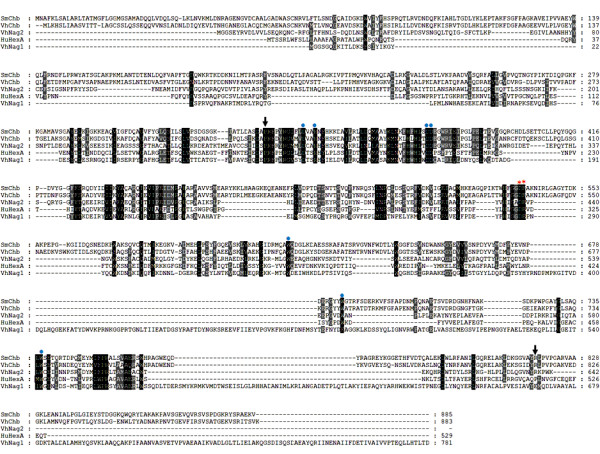
Amino acid sequence alignment of five GH-20 GlcNAcases. The sequence alignment was generated by CLUSTAL W and displayed by Genedoc. The amino acid sequence of S. marcescens chitobiase: SmChb (Swiss-Prot: Q54468) was aligned with the corresponding sequence HuHexA: the α-chain of human hexosaminidase (Swiss-Prot: P06865), V. harveyi chitobiase: VhChb (Swiss-Prot: P13670), V. harveyi 650 VhNag1(GenBank: HM175715) and VhNag2 (GenBank: HM175716). The acidic pair important for enzyme catalysis is marked with red asterisks. The residues responsible for diNAG binding are marked with blue dots. Arrows indicate the first and the last residues in the catalytic domain of SmChb.